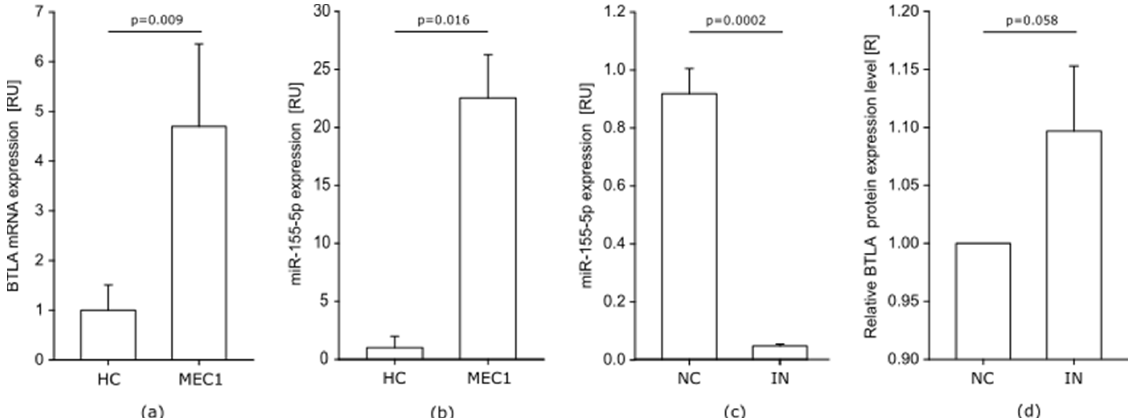
Figure 5. MEC-1 cell line. ( a , b ) BTLA mRNA and miR-155-5p are highly overexpressed in MEC-1 cells compared to median RU values of healthy controls (HC); ( c ) Downregulation of miR-155-5p in MEC-1 cells after transfection with miR-155-5p IN; ( d ) Relative BTLA protein expression level in MEC-1 cells after transfection with miR-155-5p IN; (R) Relative protein level was calculated for every experiment in MEC-1 cell line ( n = 3) as a fold change in MFI level after treatment with miR-155-5p IN compared to miR-155-5p NC, (R = MFI of IN/MFI of NC); IN- inhibitor, NC—negative control. The graphs represents mean and SD of the results of three experiments.